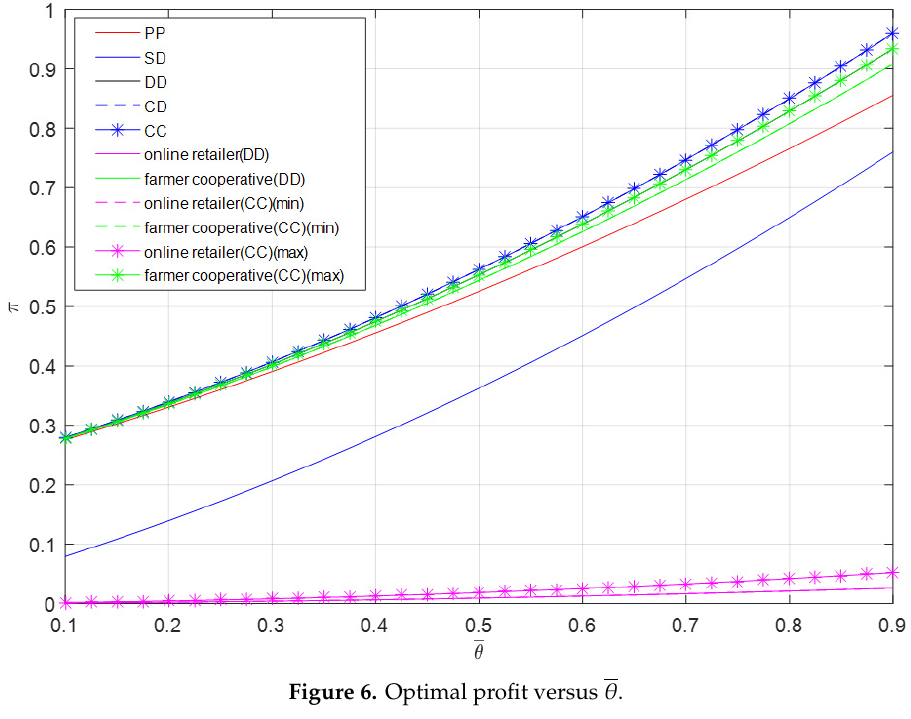
Figure 6. Optimal profit versus θ .